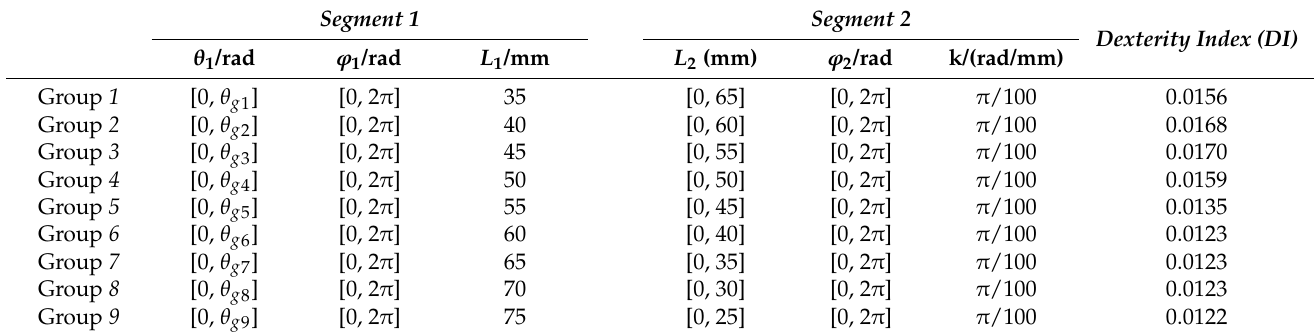
Table 5. The dexterity indices of the CCR with different length ratios.